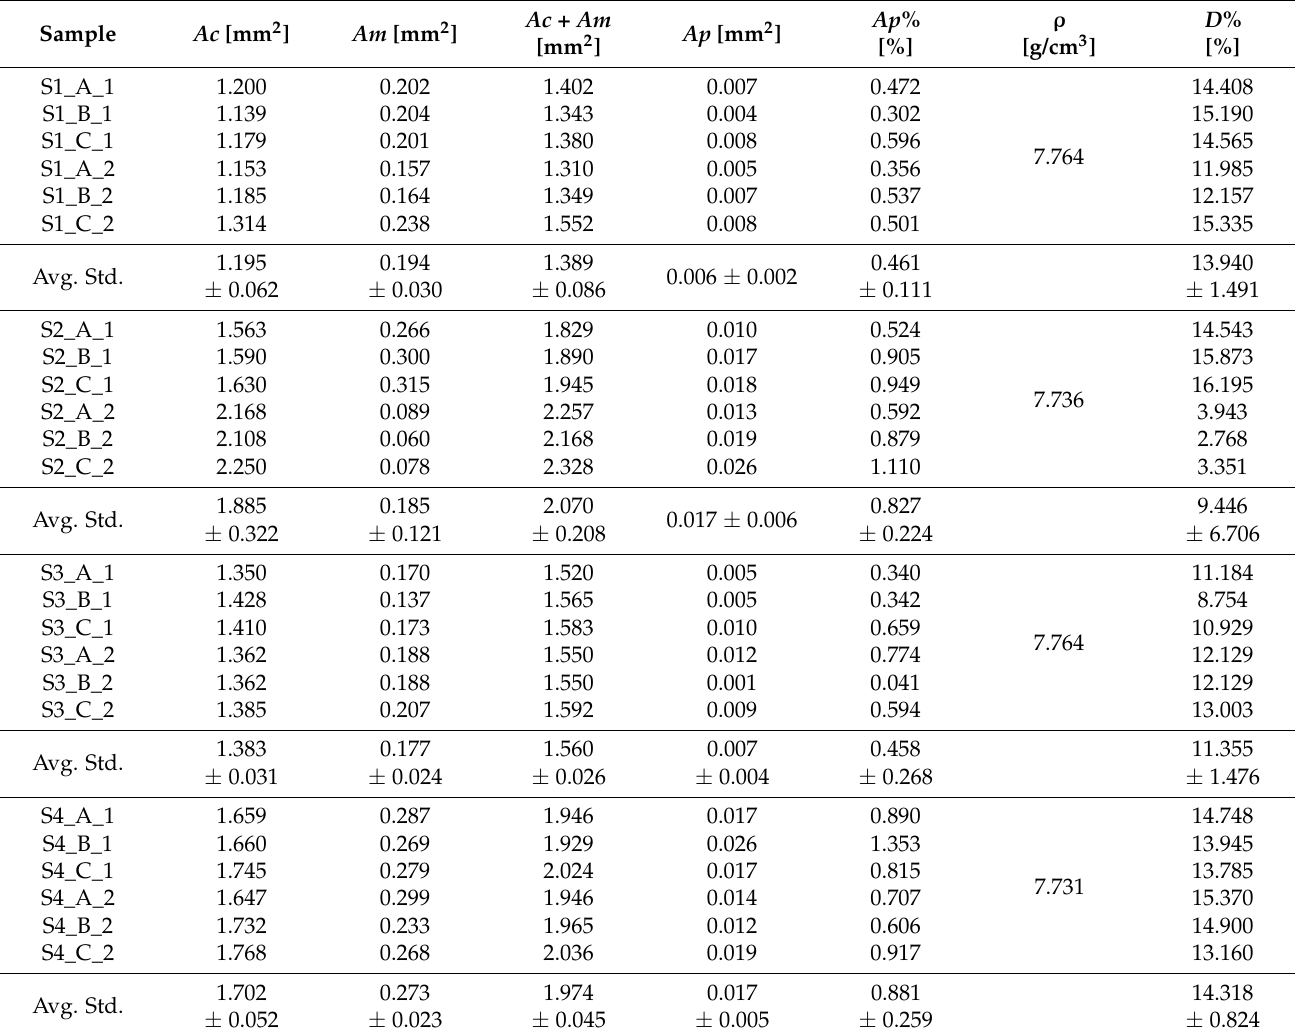
Table 6. Semiquantitative porosity measurements across the depositions: average values and the standard deviation are also